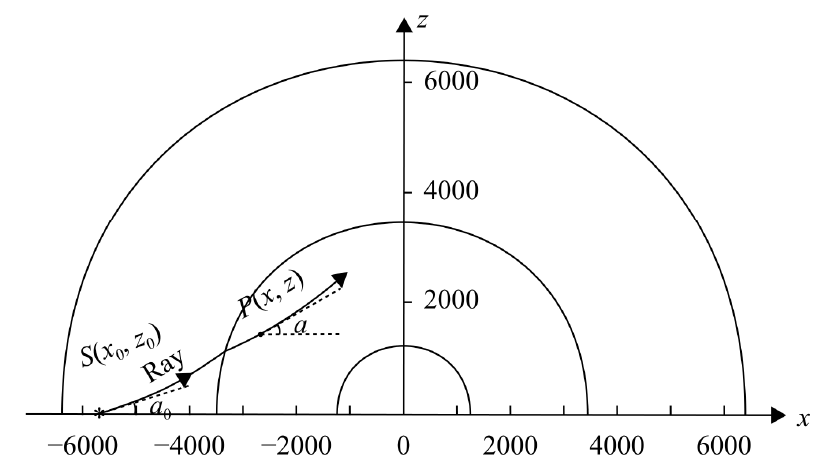
Figure 2. Schematic diagram of speed difference interface point recalculation.